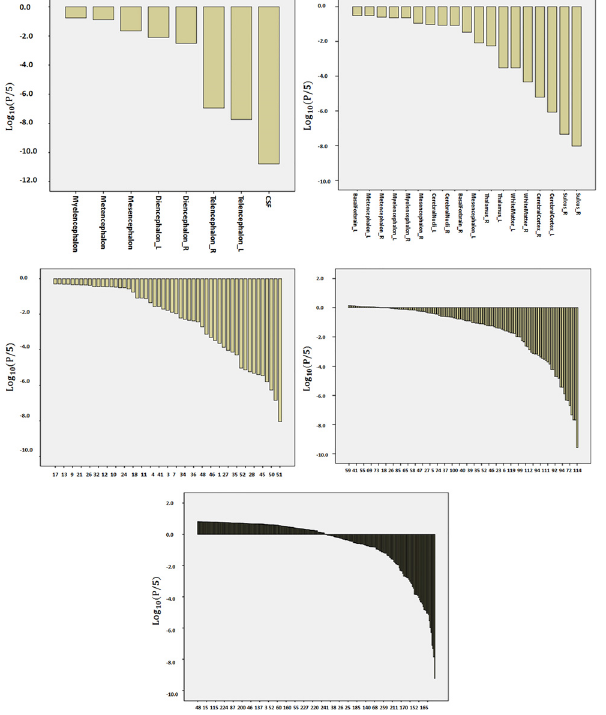
Fig 4. Distribution of Bonferroni-corrected p-values from the correlation between age and regional volumes. All the granularity levels are shown. For better visualization, the P values are presented as Log 10 (P/5). Therefore, p < 0.05 corresponds to < -2 on the y-axis.